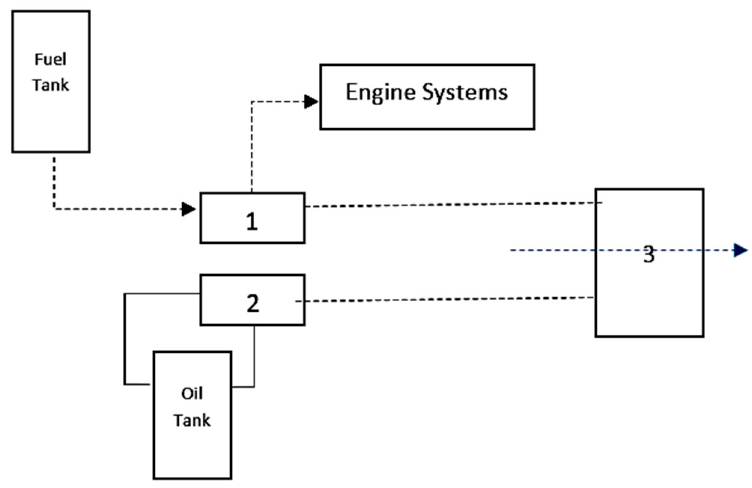
Figure 8. Thermal management system embodiments with thermally neutral heat transfer fluid.